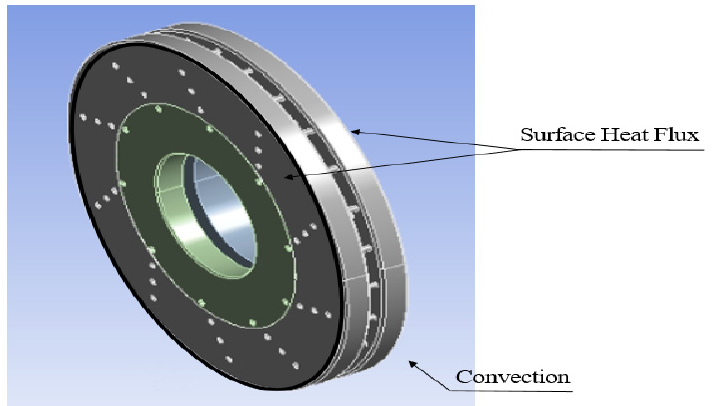
Figure 7. Boundary conditions of thermal analysis model